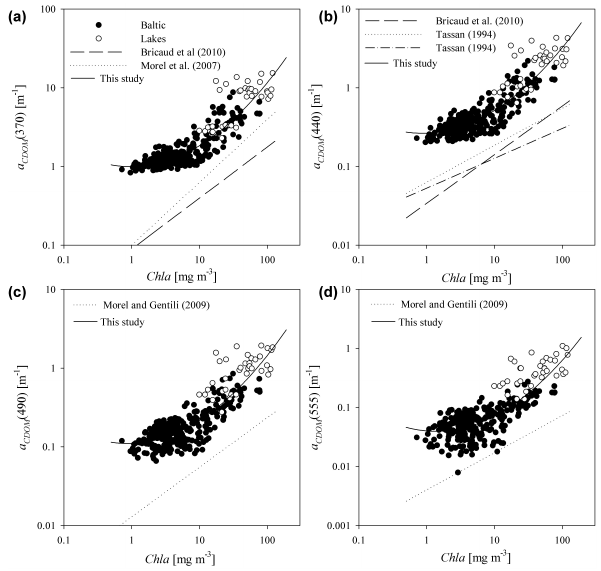
Figure 9. Comparison of the relationships between a CDOM (λ) and Chl a derived in this work and obtained by different authors for different waters adapted to the data analyzed in this